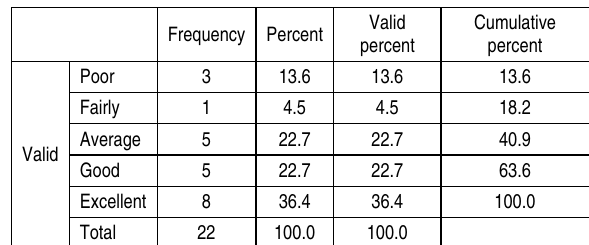
Table 15. Meeting the objectives of the SBIC project